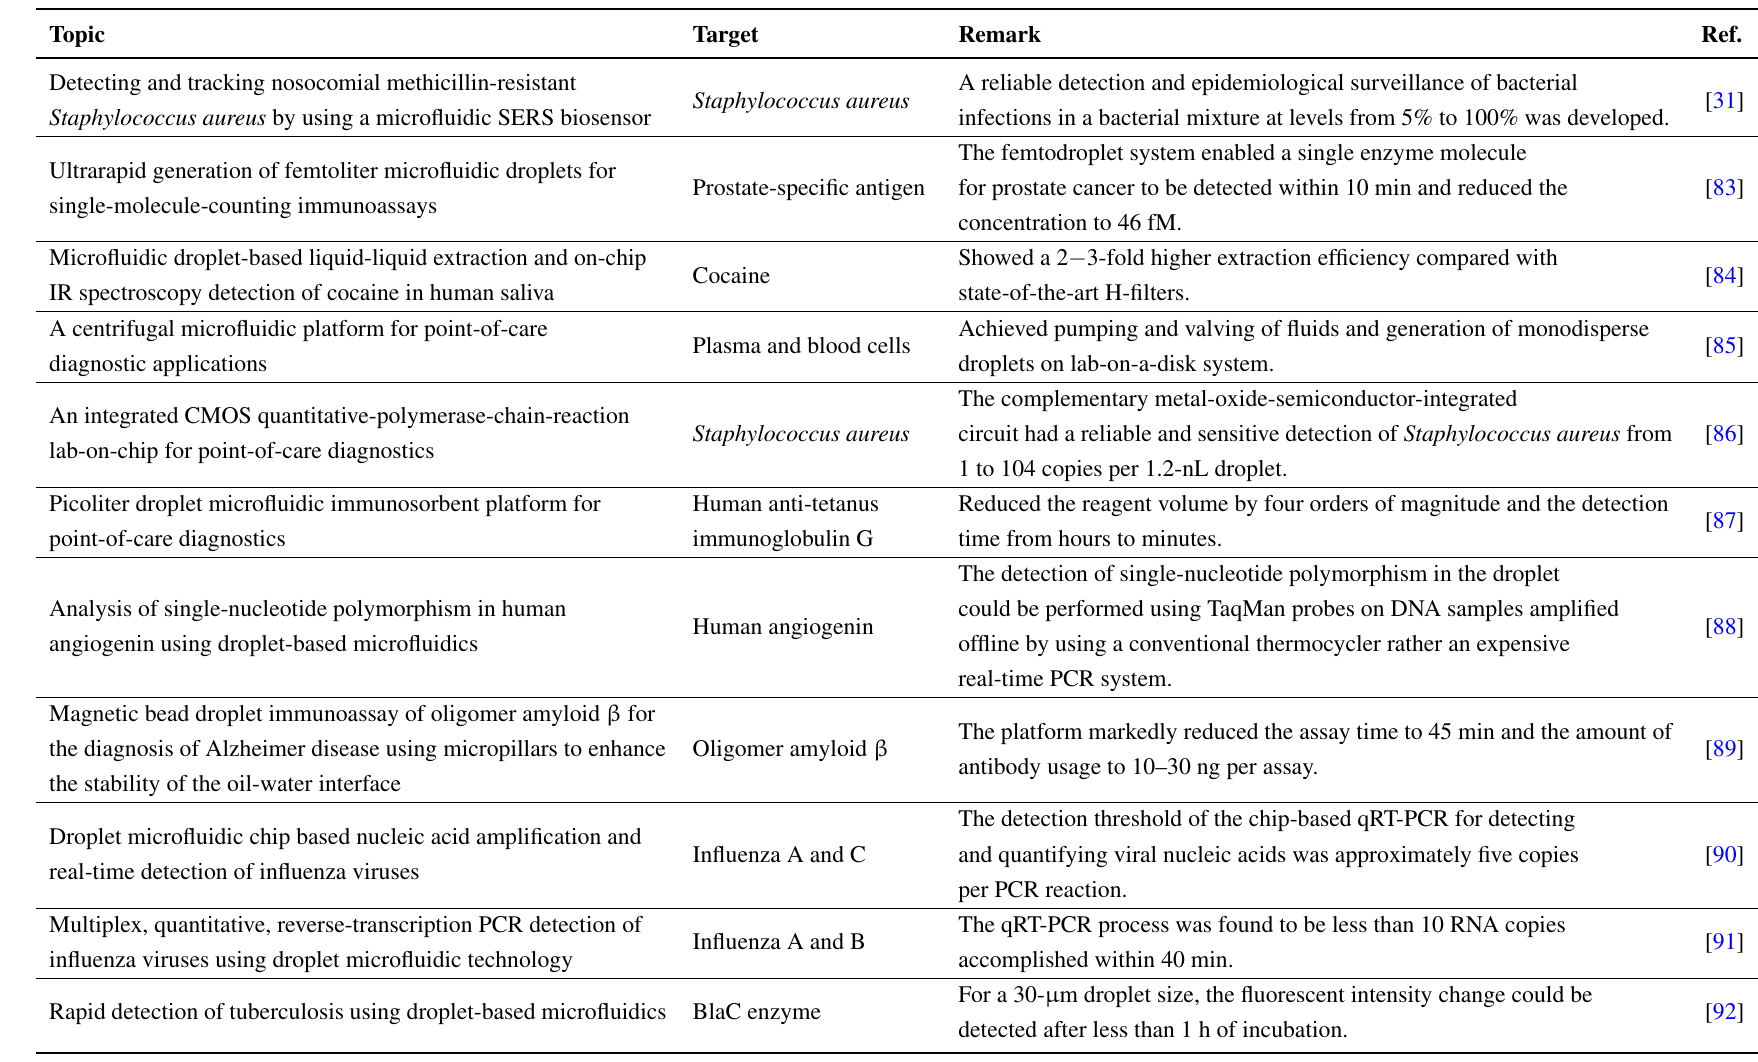
Table 4. Recent applications of droplet microfluidics in diagnostic